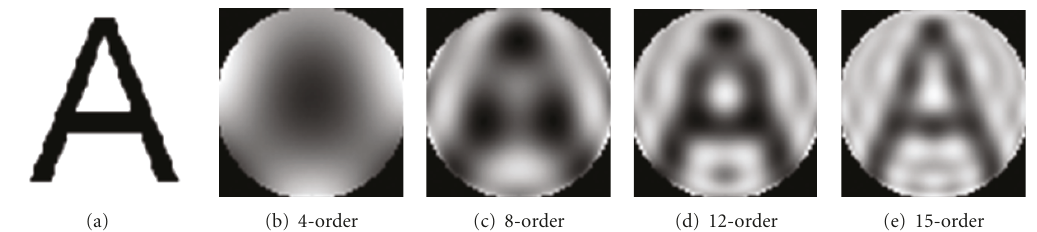
Figure 1: Reconstruction of a gray image. From left to right: the original image, the reconstructed image with order 4, 8, 12 and 15, respectively.